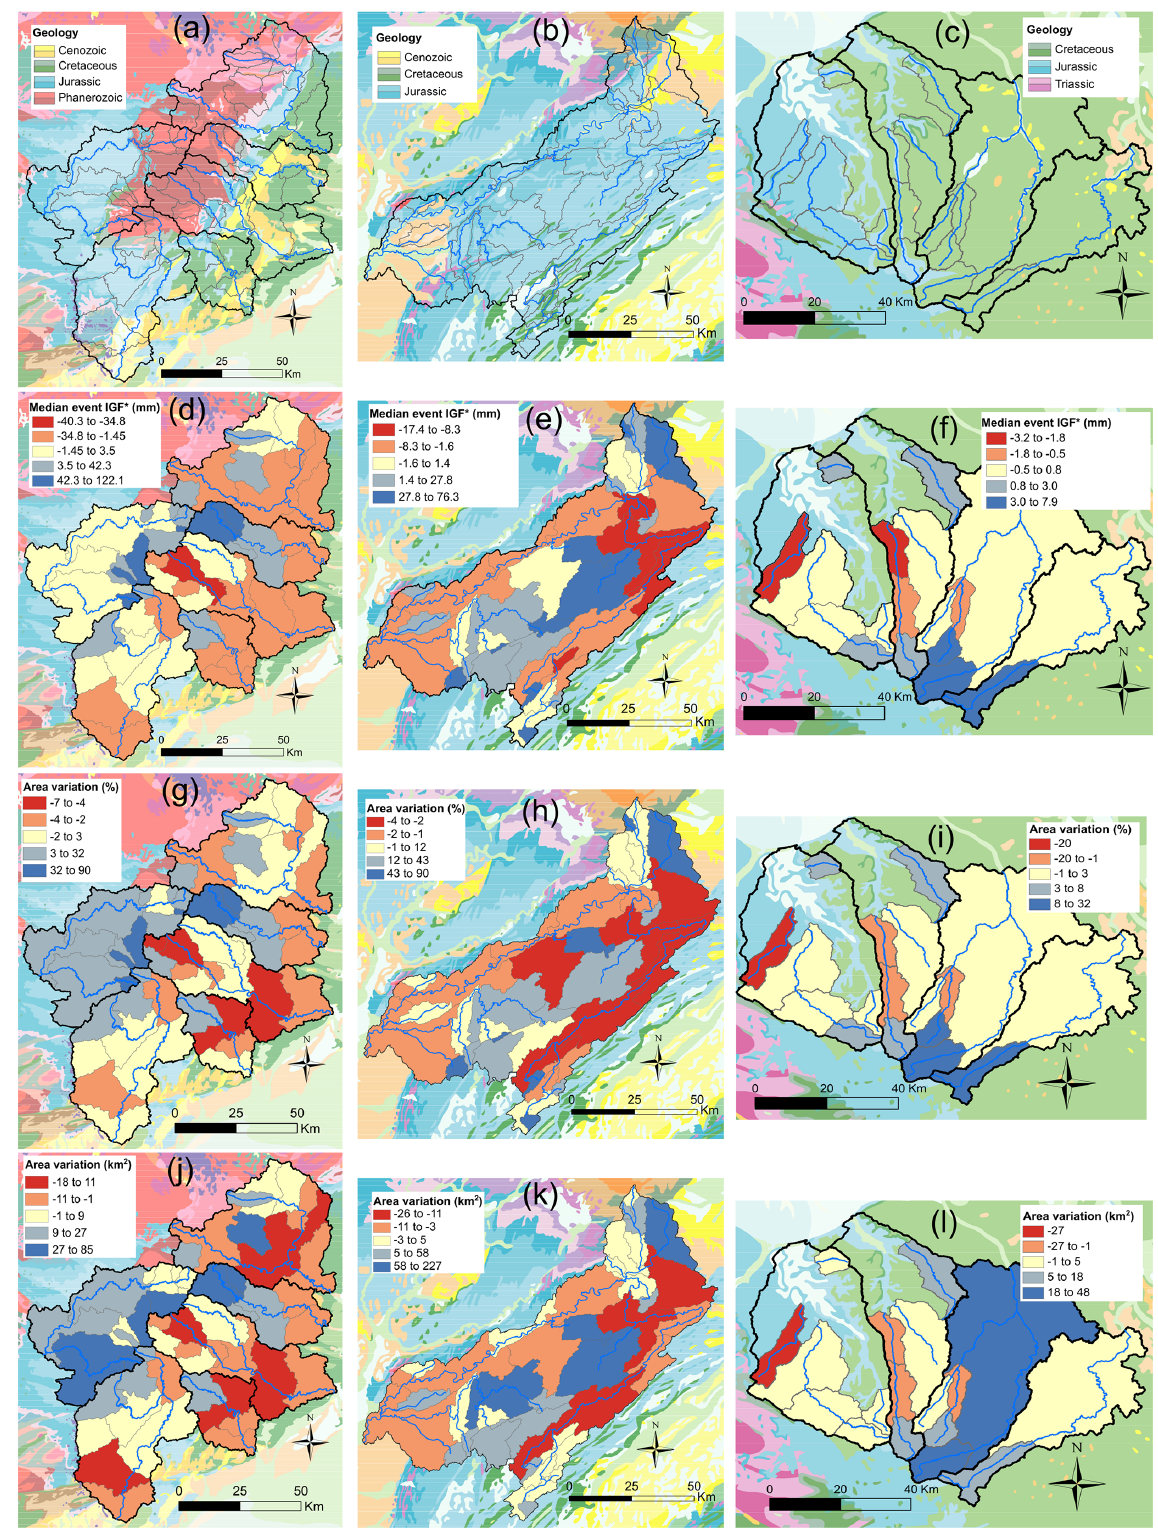
Figure 9. Main geological features in the three studied areas (a, b, c) , median storm-event IGF ∗ values (including potential aquifer storage variation) (d, e, f) , and area variation from actual topographic to theoretical hydrogeologically active catchment [in %] (g, h, i) and in square kilometres [km 2 ] (j, k, l)